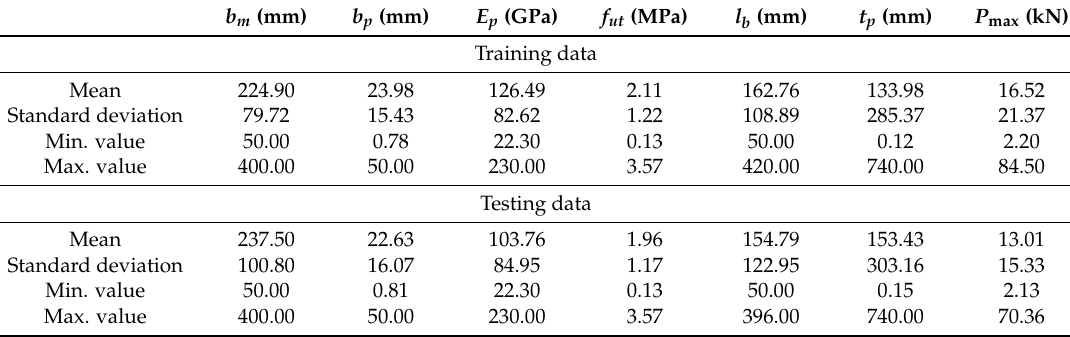
Figure 2. Observed and predicted debonding forces by GEP (gene expression programming) for ( a ) training dataset and ( b ) testing dataset. Table 3. Statistics for the experimental data.